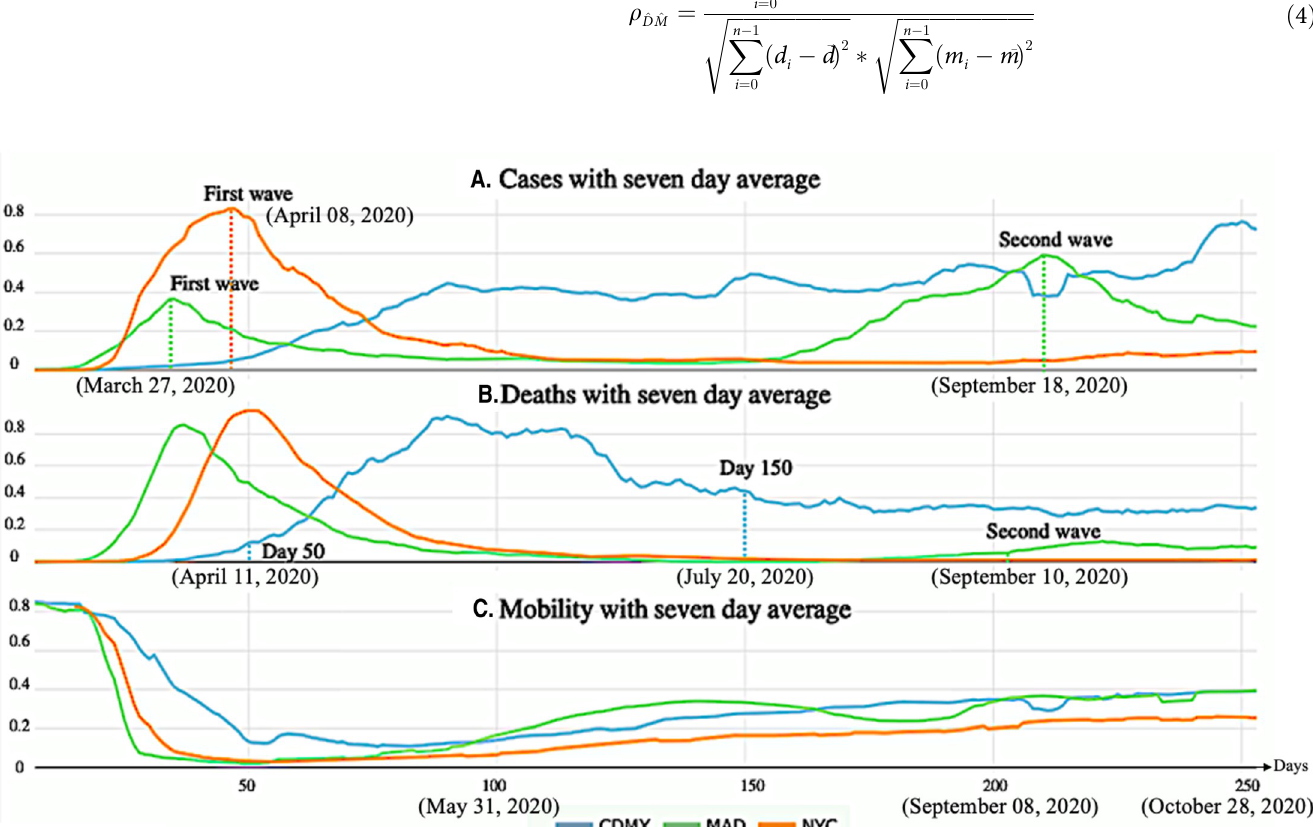
Fig 1. Seven-day average. Section A: MA with m = 7 for positives cases. Section B: MA with m = 7 for deaths due to COVID-19. Section C: MA with m = 7 for mobility index. https://doi.org/10.1371/journal.pone.0264713.g001 PLOS ONE | https://doi.org/10.1371/journal.pone.0264713 March 17,